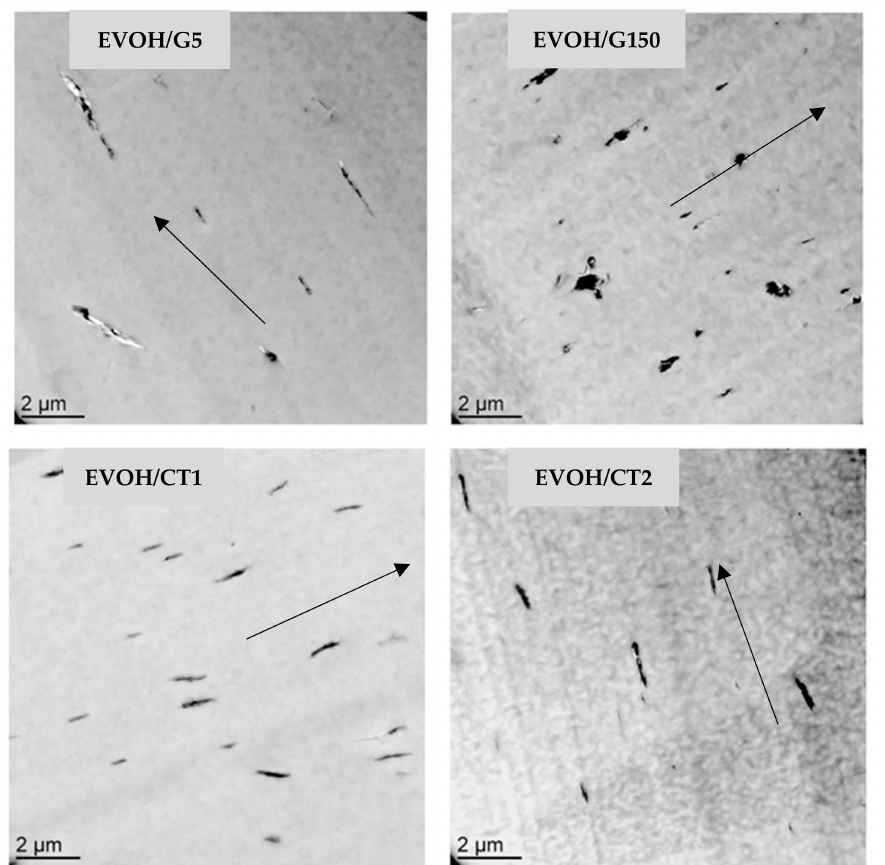
Figure 1. TEM micrographs at low magnifications of the studied nanocomposites as a function of the filler type (filler rate = 2 wt%)—the arrows indicate the preferential orientation of the fillers which is parallel to the film